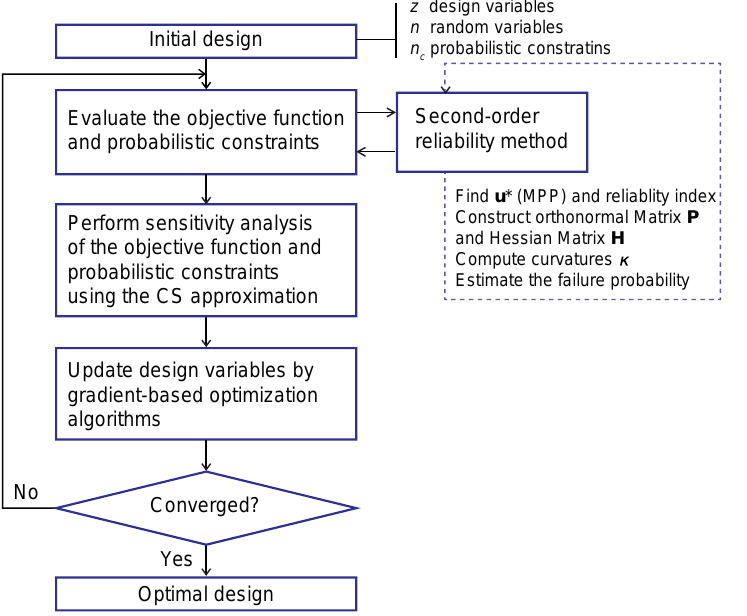
Figure 2. Process flow of the reliability-based design optimization (RBDO) using the complex-step (CS) derivative approximation with SORM/SORM-i